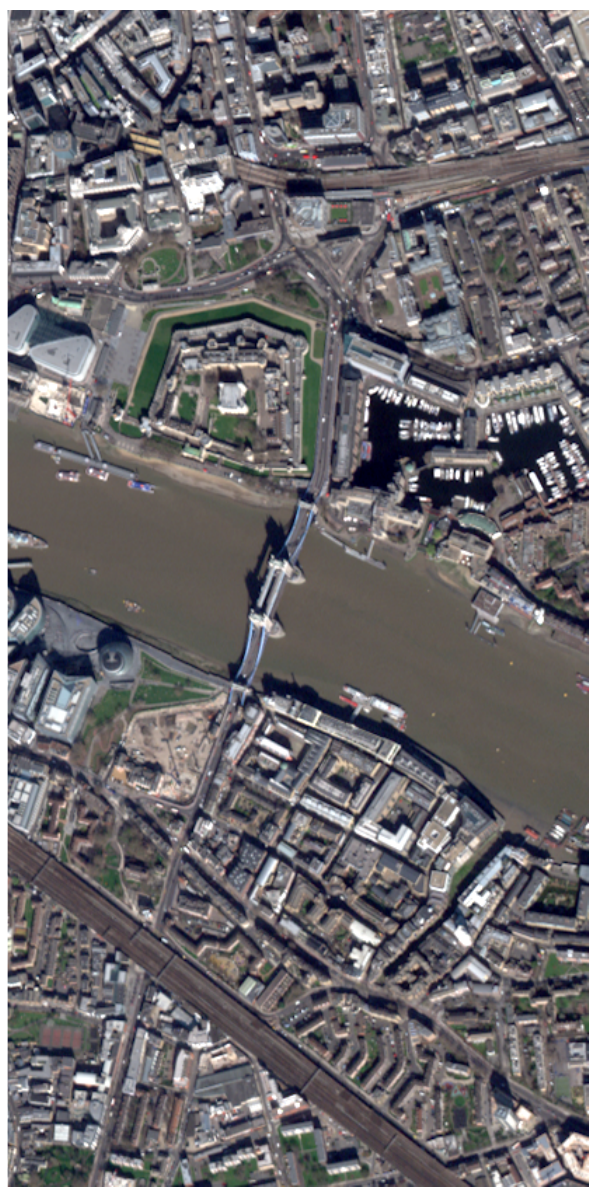
Figure 2 : Pan image at source resolution. Courtesy of Digital